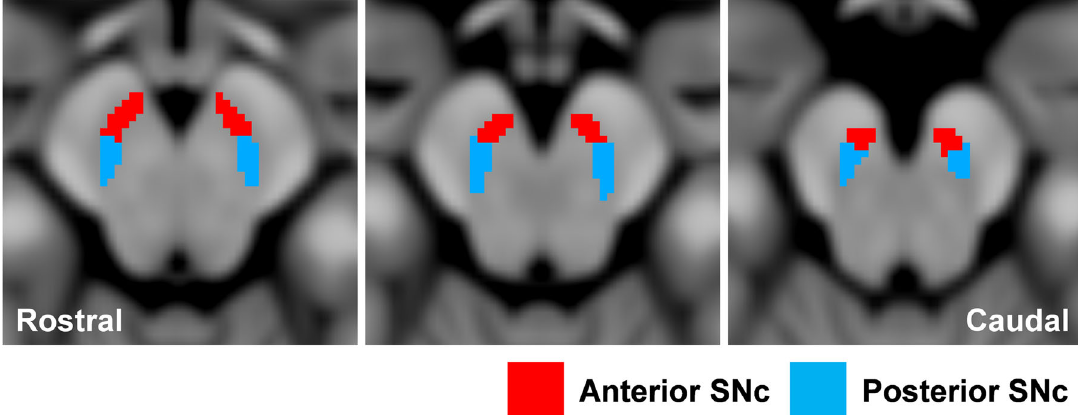
Fig. 3 The anterior and posterior ROI of substantia nigra pars compacta. The SNc ROI was automatically created with using automated anatomical atlas 3rd version (AAL3). The anterior substantia nigra (aSN; blue) and the posterior substantia nigra (pSN; red) were manually divided in the middle of each section of SNc atlas (see Methods). ROI region-of-interest, SNc substantia nigra pars